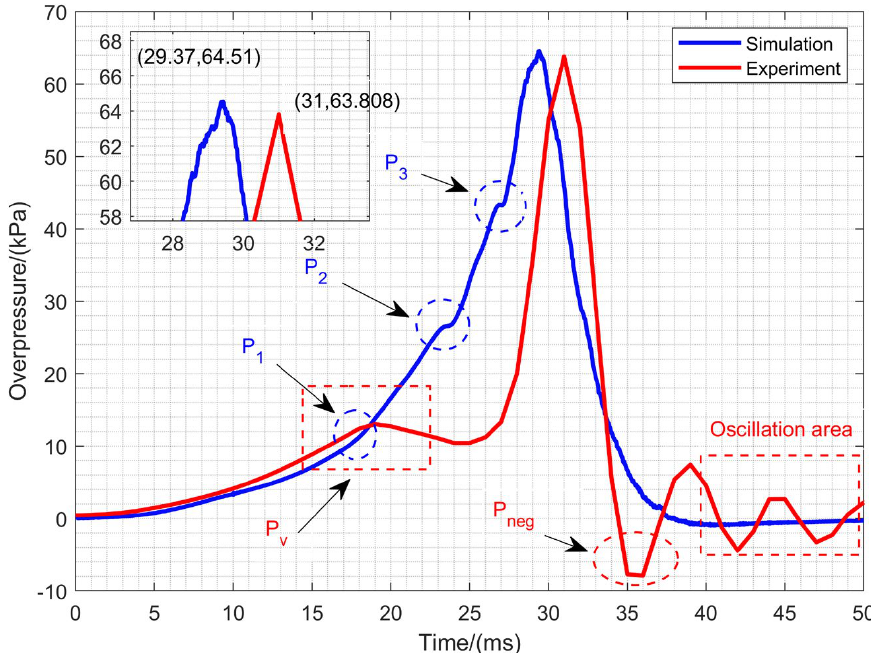
Figure 5. pressure comparison at 30 mm to the right of the ignition point. Figure 5. Pressure comparison at 30 mm to the right of the ignition